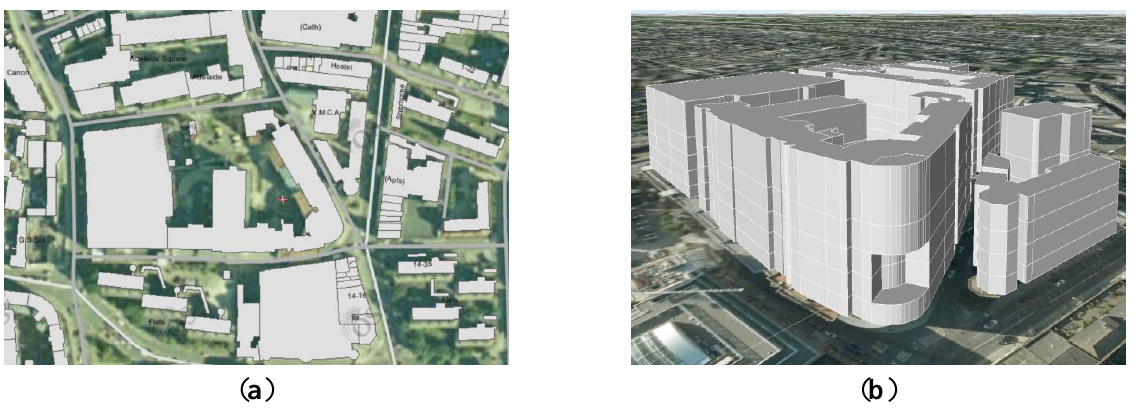
Figure 4. ( a ) 2D footprint testbed data of Dublin Institute of Technology (DIT) campus in Dublin ( b ) Extruded 3D building models at same location.